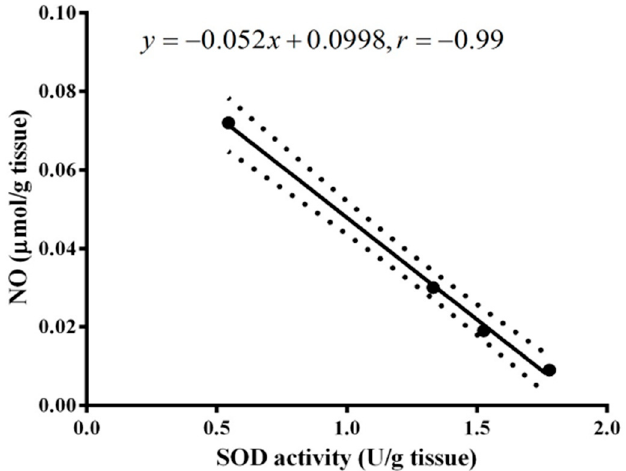
Figure 10. Relationship between brain NO and SOD levels two months following MSG administration of all the experimental groups. The correlation coefficient is − 0.99, i.e., an inverse relationship between the NO and SOD at two months post-treatment. The distance between the dotted curves is the correlation area which involves the data and the line represents the regression strength indicator, i.e., the close the data to linear line, the strong the correlation.